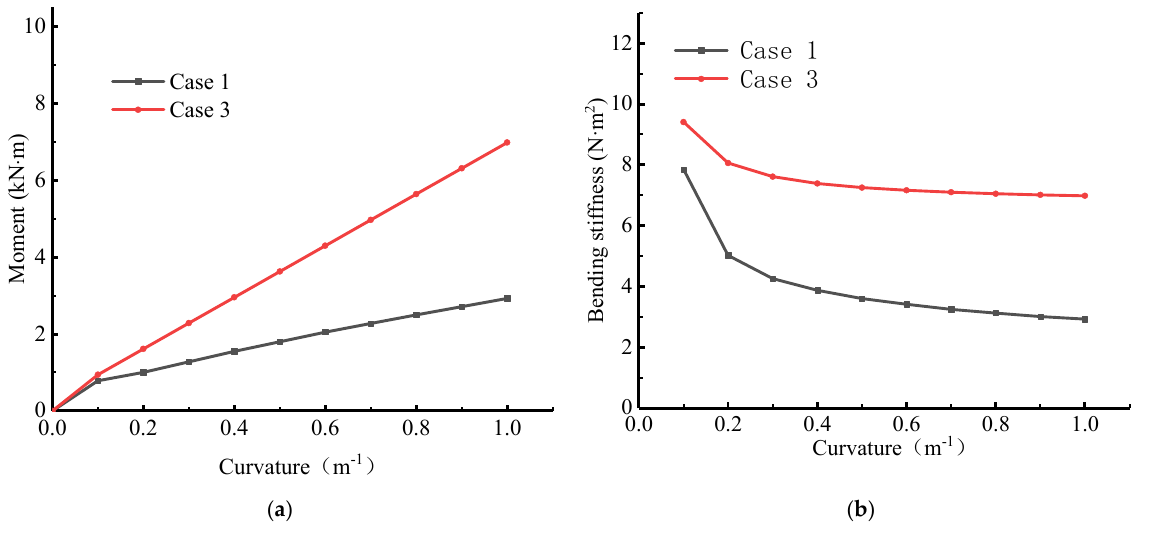
Figure 13. Bending moment and stiffness. ( a ) Moment–curvature; ( b ) bending stiffness.